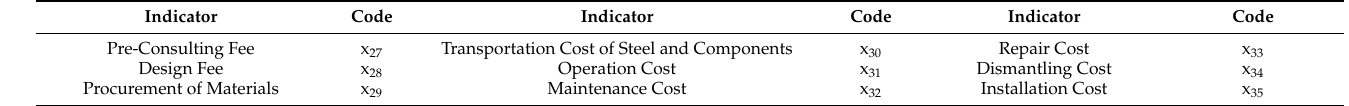
Table 3. The economic